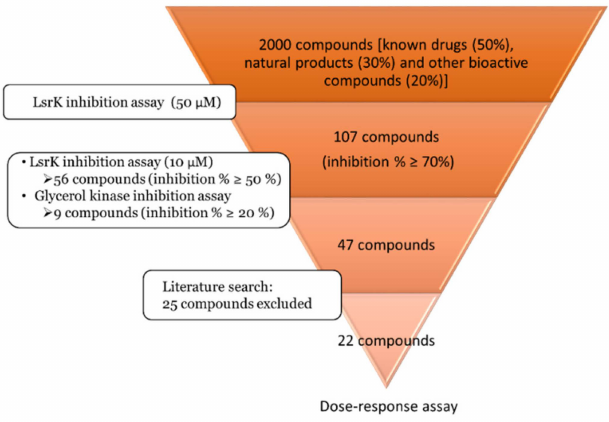
Figure 3. Workflow of the screening